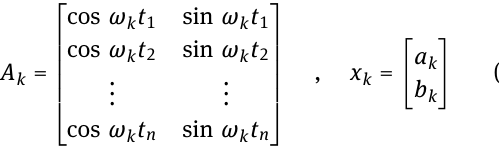
Figure 6: Original time series of parameter Z for station (a) GRAZ, (b) ONSA, (c)